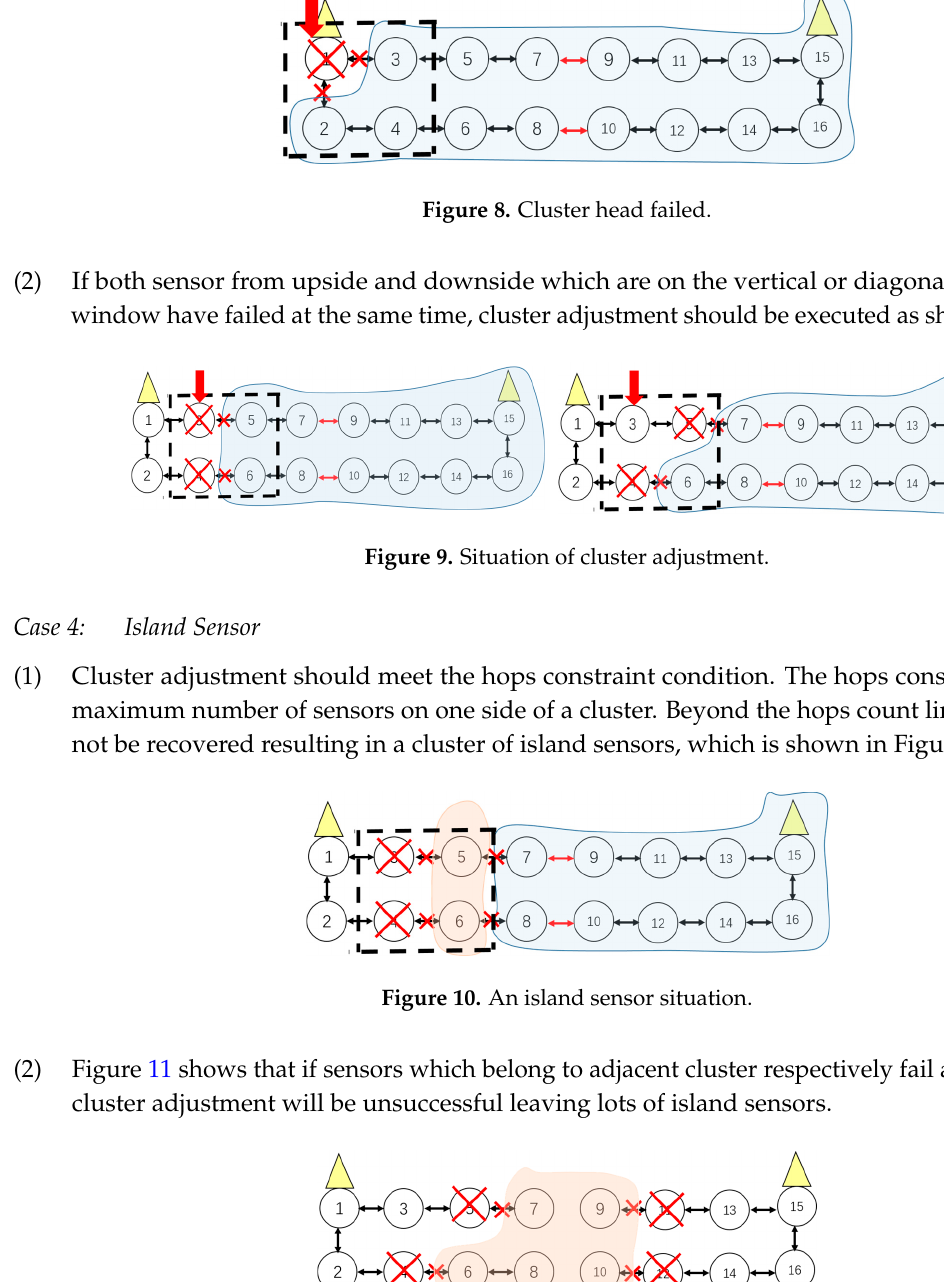
Figure 7. Situation of Route Adjustment.